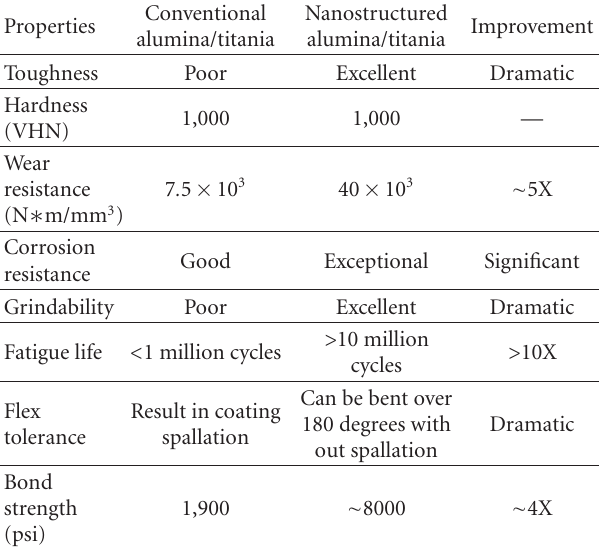
Table 1: Comparison of conventional and nano